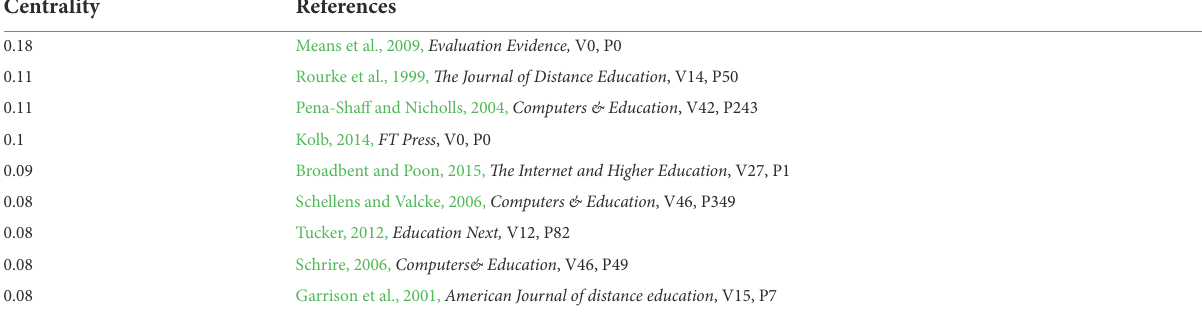
TABLE 9 Top nine references by centrality.